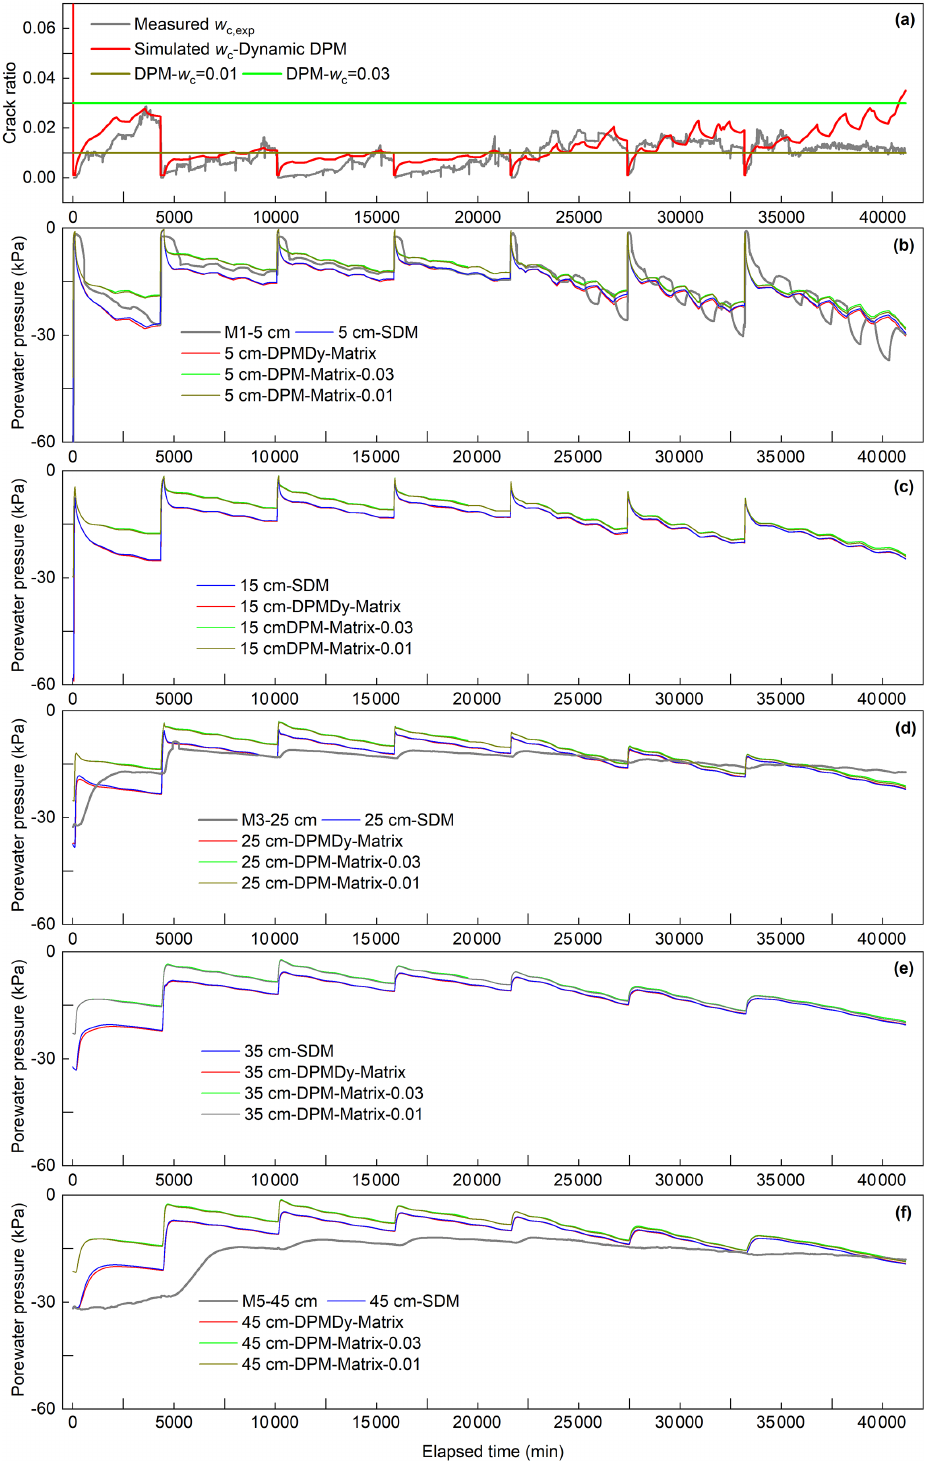
Figure A2. Temporal evolution of the measured and simulated volumetric water content at depths of 5, 15, 25, 35 and 45cm. Note that the simulated volumetric water content demonstrated here is the total volumetric water content that was combined with the combined matrix and crack domains using Eq.